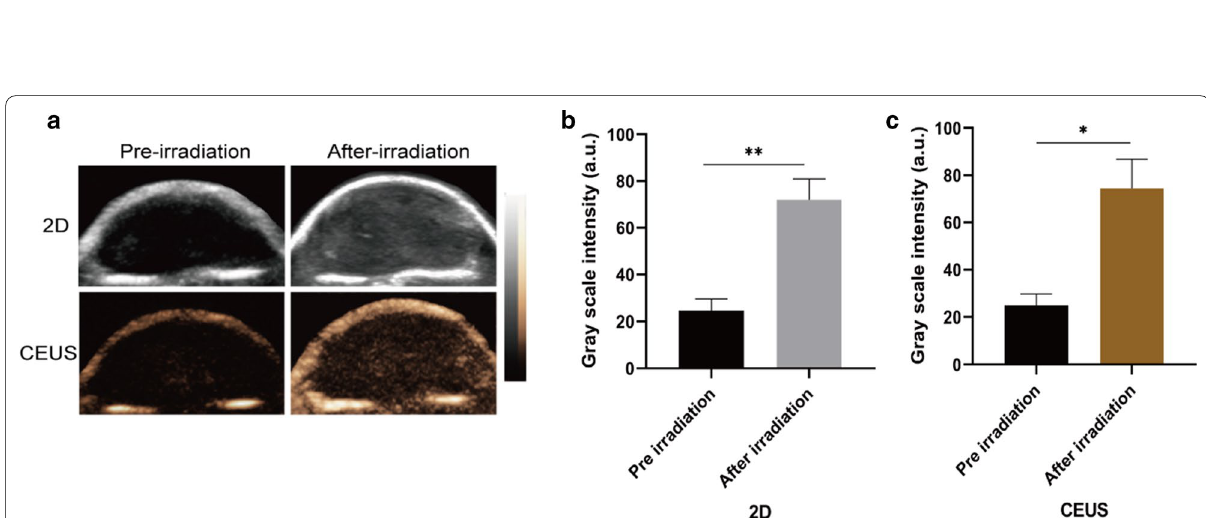
Fig. 7 a 2D and CEUS images with and without LIFU irradiation. b , c The corresponding grayscale intensity analysis measured by ImageJ (** p < 0.01, * p < 0.05, n =